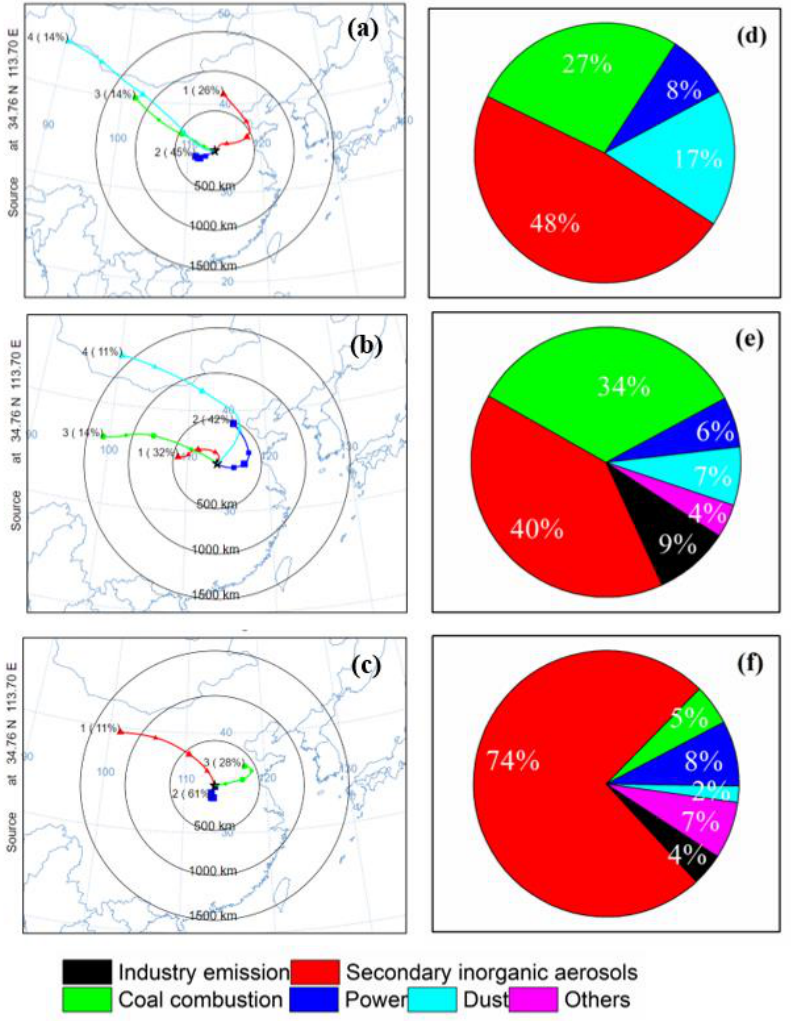
Figure 5. Examples of cluster mean 48 h backward air trajectories and source contribution fractions to PM 2.5 in PP1 ( a , d ), PP2 ( b , e ), and HOP ( c , f ).